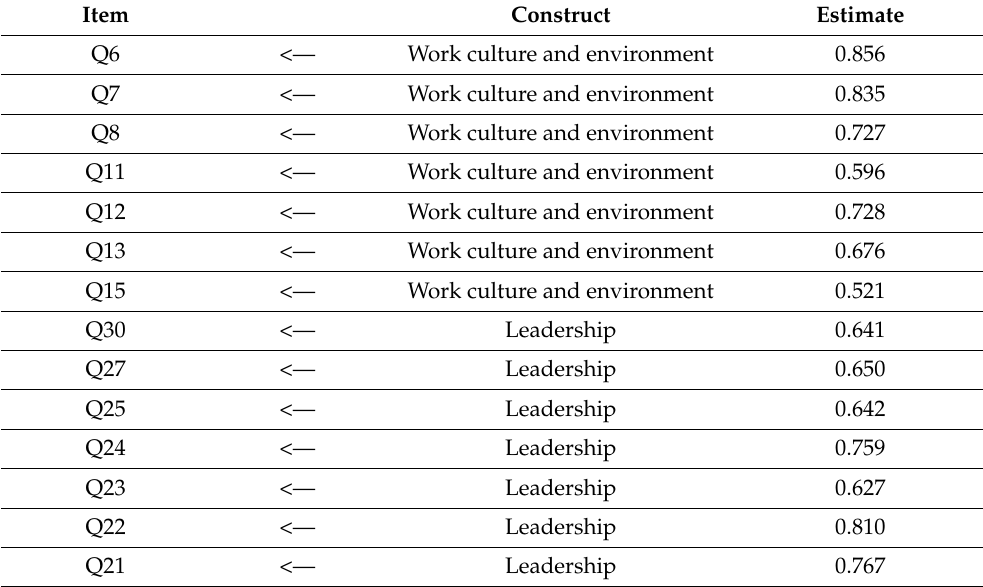
Table 5. Standardized regression weights.